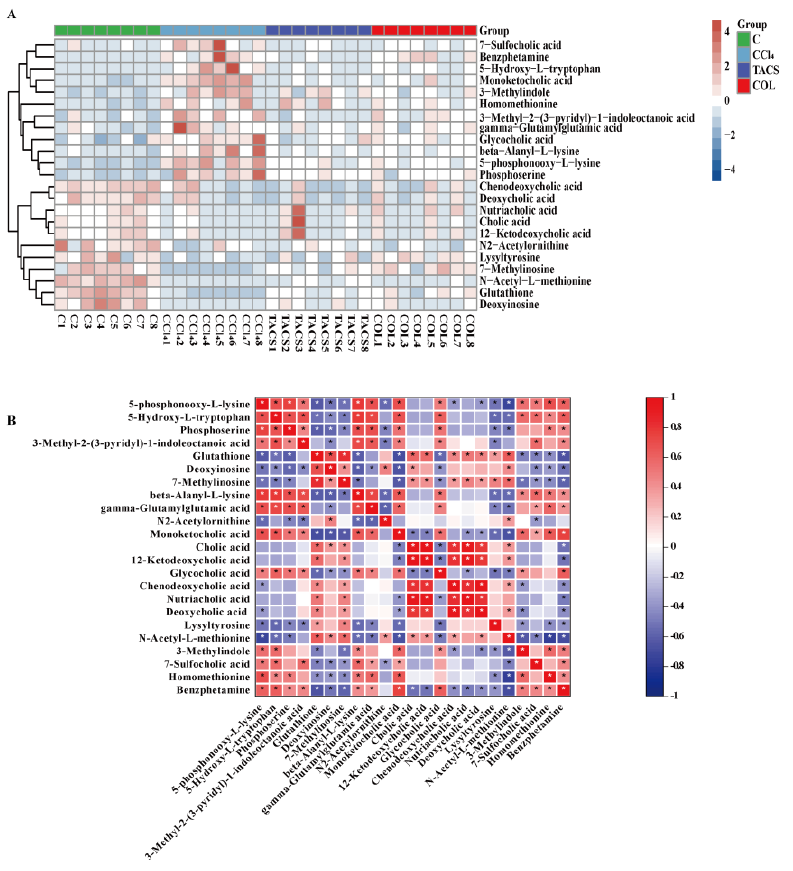
Figure 5. Identification of potential biomarkers for liver fibrosis. ( A ) Heatmap of the differential metabolites of liver fibrosis affected by TACS and COL. Blue: down−regulated; red: up−regulated ( n = 8). ( B ) Spearman correlations between the differential metabolites. Red: significant positive correlations, blue: significant negative correlations. * p < 0.05.